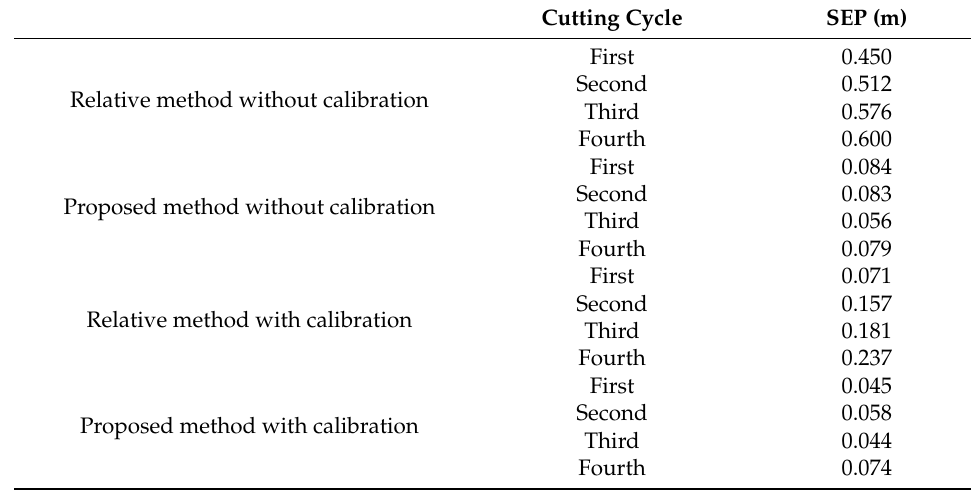
Table 3. SEP in each cutting